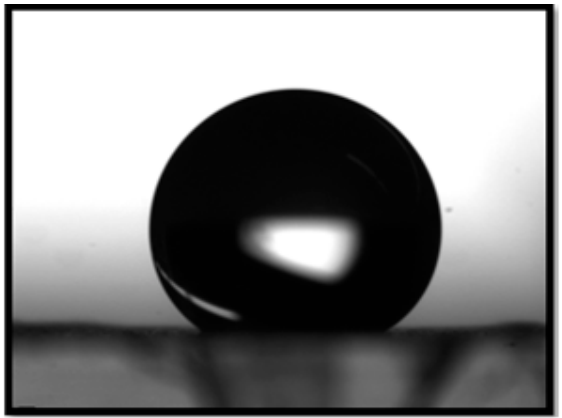
Figure 6. The permeability of the catalyst calculated over the thickness of the fiber mat was 4.4363 × 10 (cid:2879)(cid:2877) m. 4.4363 × 10 (cid:2879)(cid:2877) m.